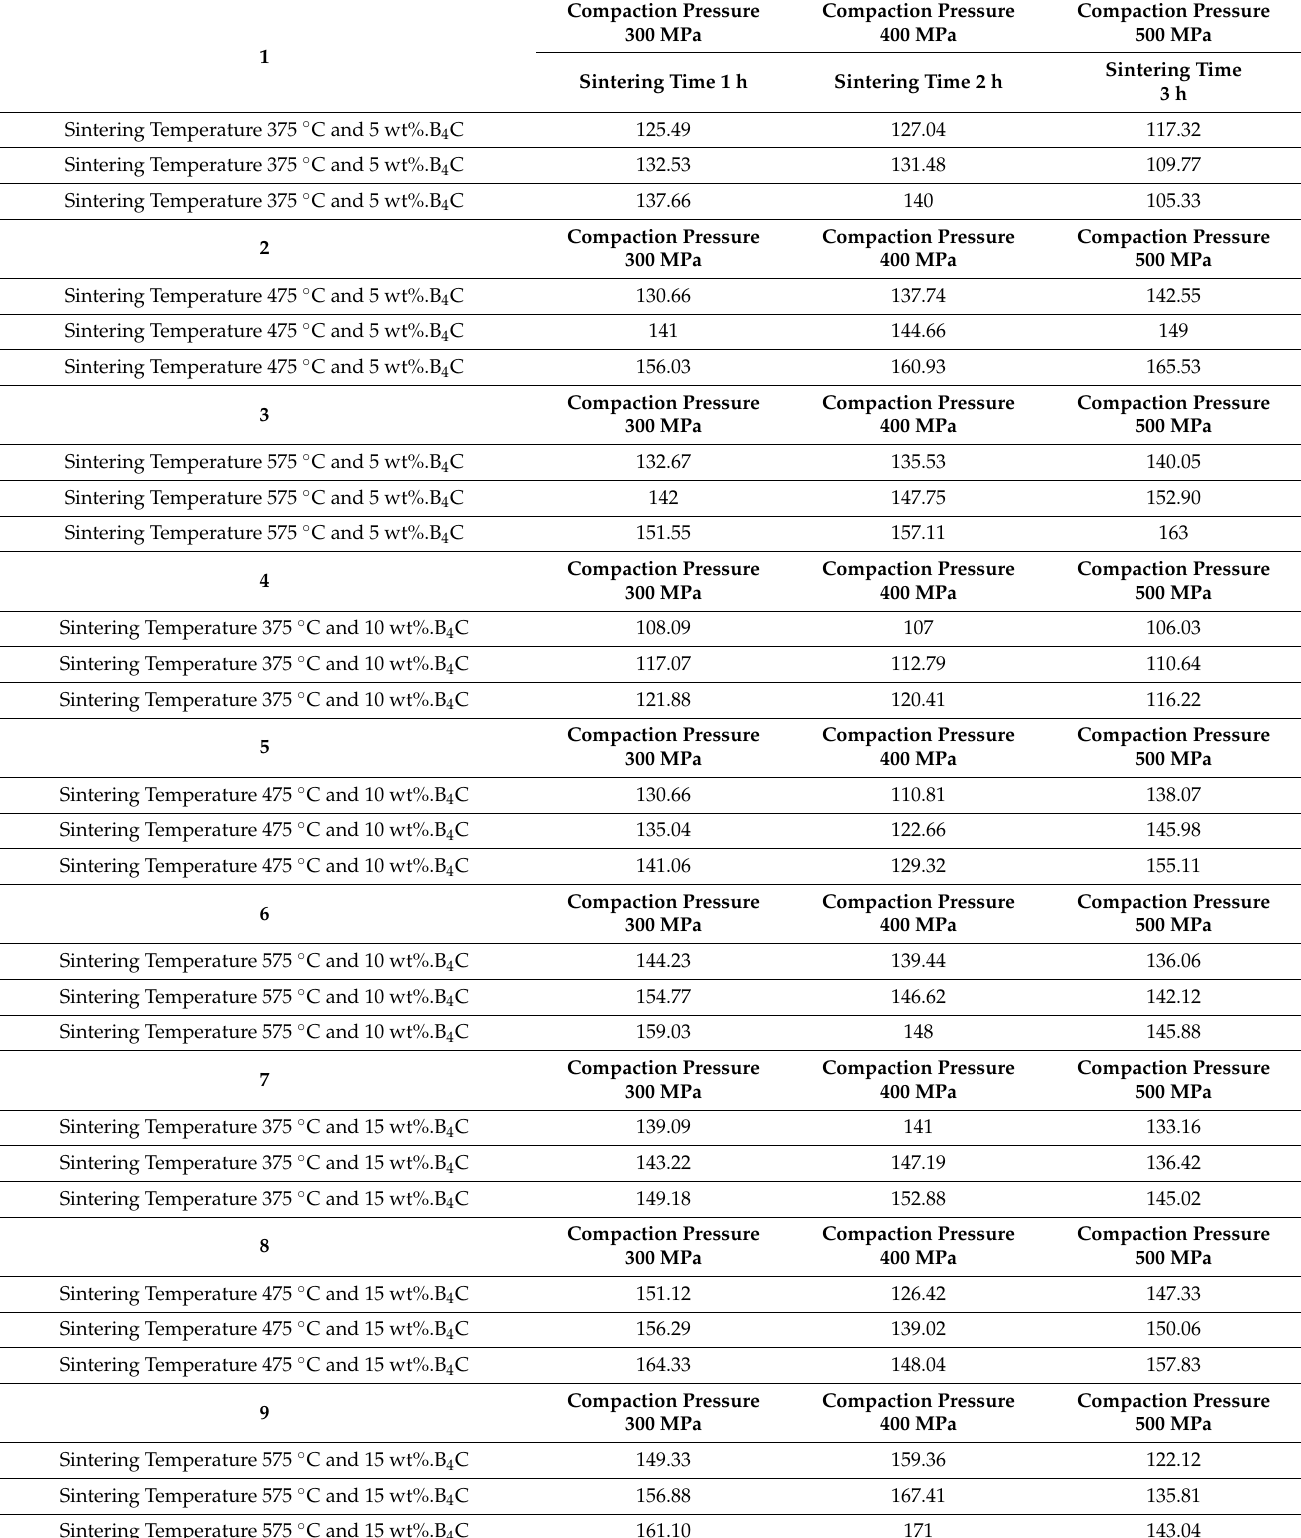
Table 3. Effect of PM parameters on compressive strength at different compaction pressure (300, 400, and 500 MPa), different sintering time (1, 2, and 3 h), different sintering temperature (375, 475, and 575 ◦ C), and different reinforcement weight percentages (5 wt%., 10 wt%., and 15 wt%.B 4